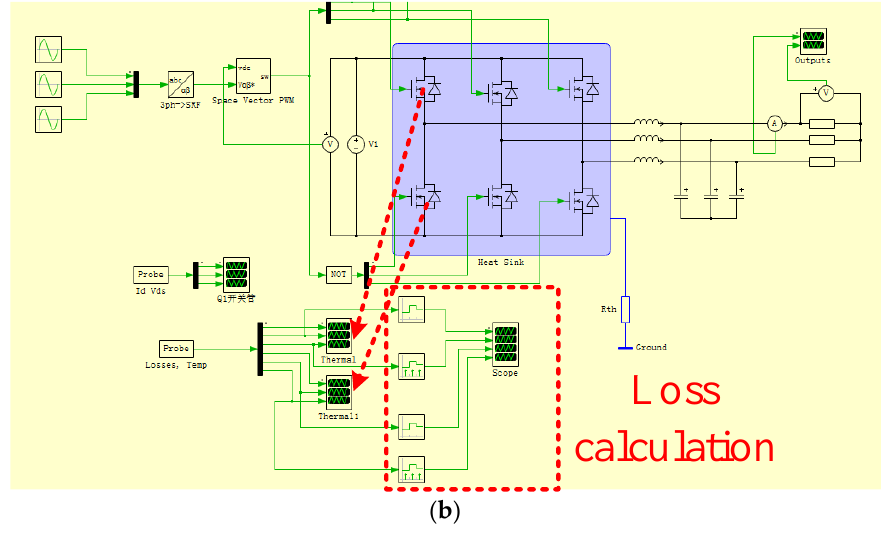
Figure 13. The PLECS loss simulation model, ( a ) the model of the DC/DC converter, ( b ) the model of the three-phase inverter.